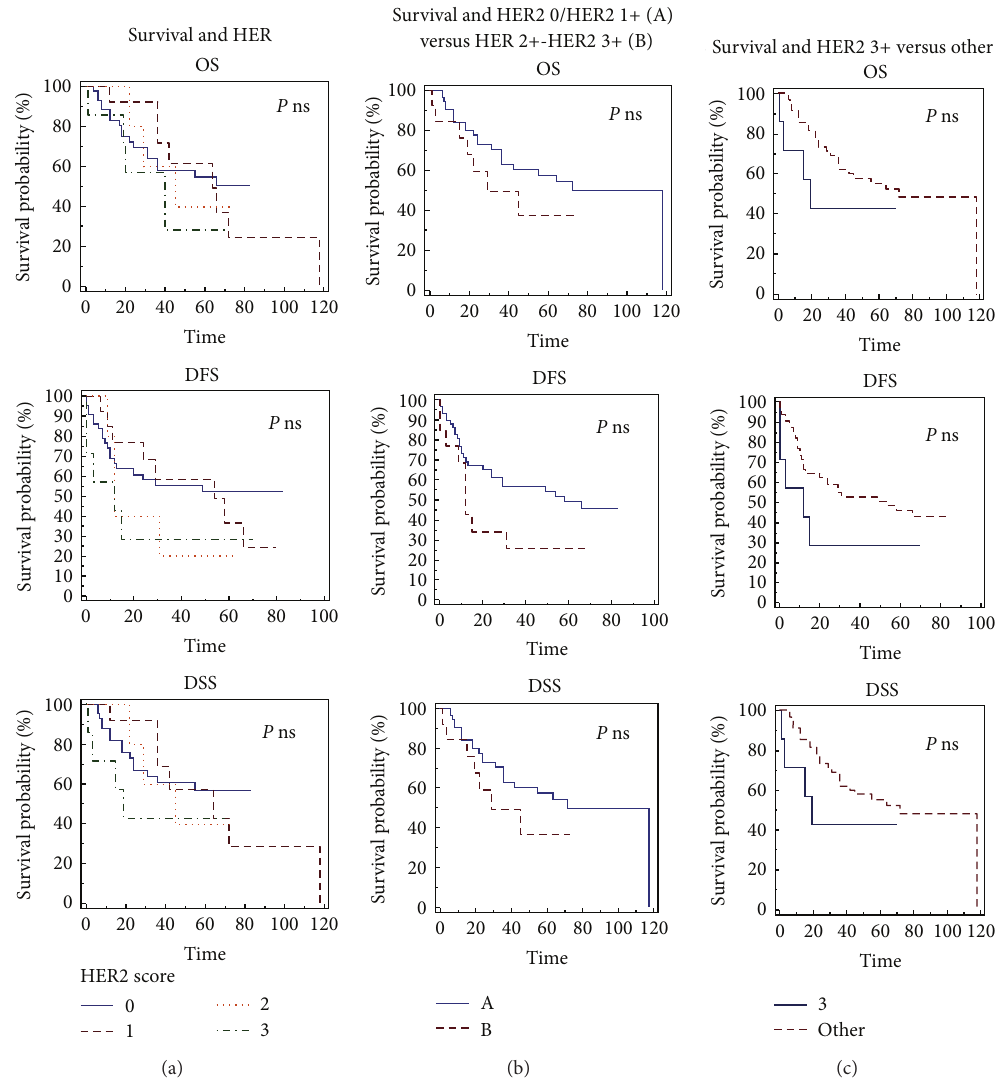
Figure 5: Gastric cancer and HER2 overexpression related survivals. (a) Overall survival, disease free survival and disease specific survival of gastric cancers according to the IHC scoring; (b) overall survival, disease free survival and disease specific survival analysis: negative tumors (HER2 0 and HER2 1+) versus equivocal/positive tumors (HER2 2+ and HER2 3+); (c) overall survival, disease free survival and disease specific survival: positive tumors (HER2 3+) versus other negative/equivocal tumors (HER2 0, HER2 1+, HER 2